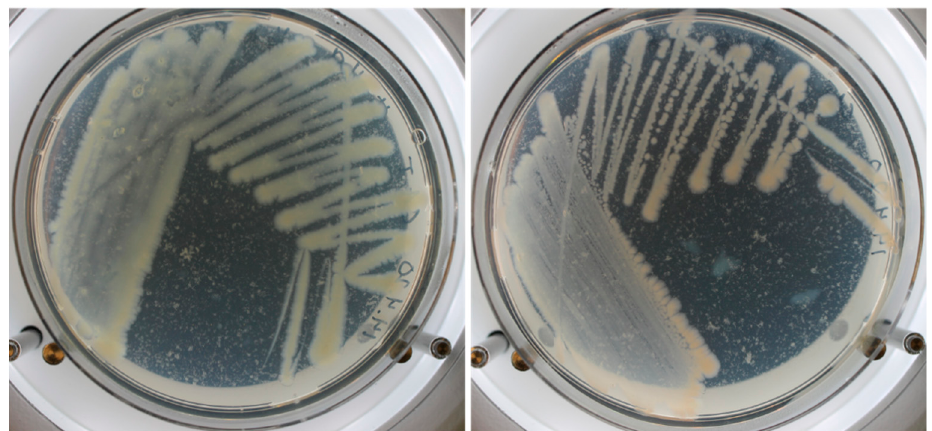
Figure 6. Wild-type V. cholerae strain Vc-7 and V. cholerae clone no. 120. Left: Wild-type strain; right: RFP-tagged V. cholerae clone no. 120. Clone 120 produces a slight reddish pigment in comparison to the WT strain after two day’s growth, due to the strong RFP expression. Both the WT strain and clone were freshly struck from 15% glycerol stocks (frozen at − 80 °C) onto MB agar without antibiotics. The plates were incubated at 37 °C for two days. The plates are illuminated from the sides. Images taken from the lids of the plates.